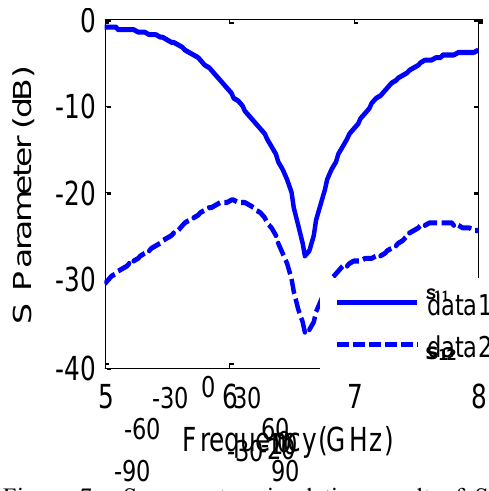
Figure 7: S-parameter simulation result of SDRA antenna array with DGS. Figure.8 represents the radiation patterns in different planes for DGS at 6.62 GHz, a very little variation in radiation pattern. By filling the slot with dielectric material, ε =2.2, the isolation about 17. 5dB at 6.6 GHz. r1